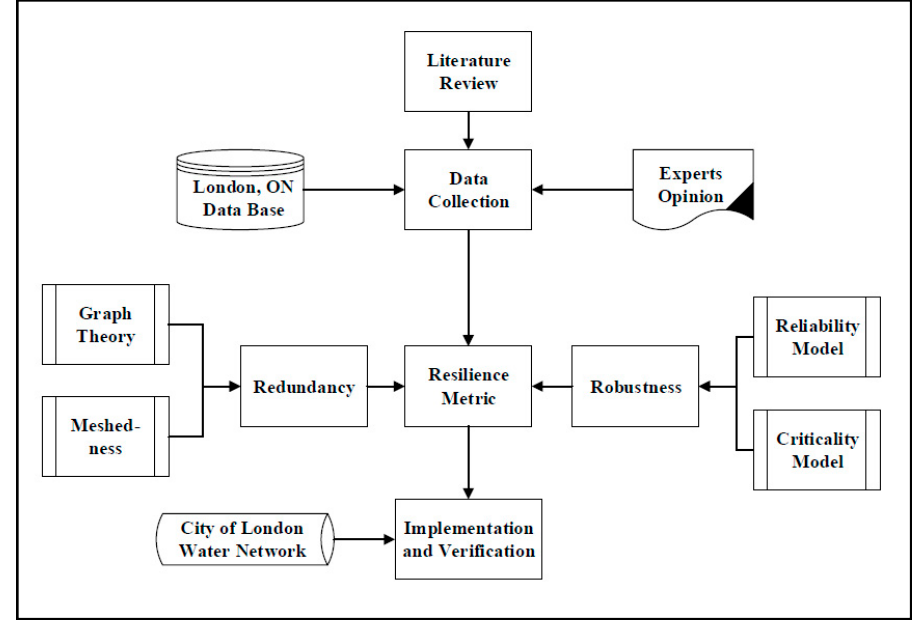
Figure 3. Resilience metric development methodology.